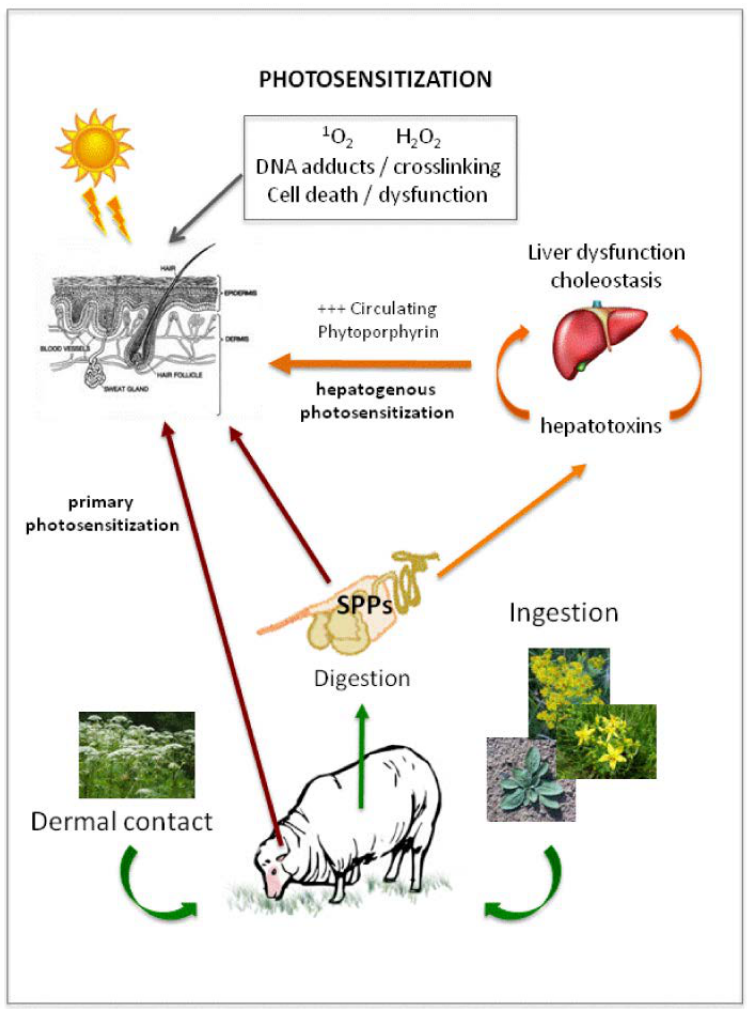
Figure 3. Modes of delivery to the skin of common photosensitizing compounds affecting domestic livestock in primary or hepatogenic